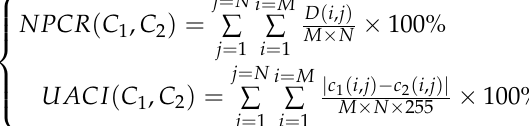
Table 5. Results of Information entropy.